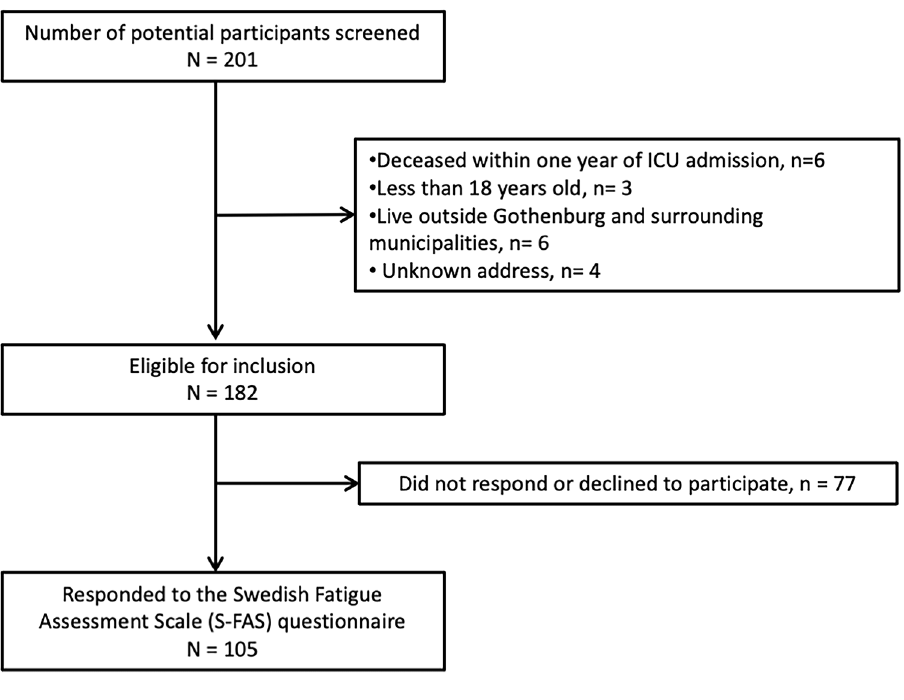
Figure 1. Flowchart of the inclusion